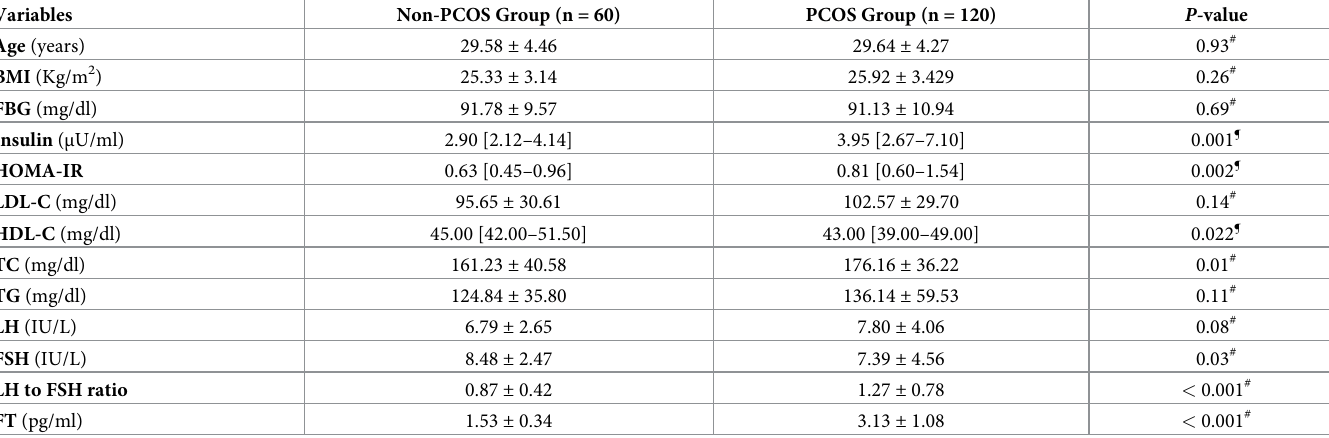
Table 1. Clinical features of the study population.